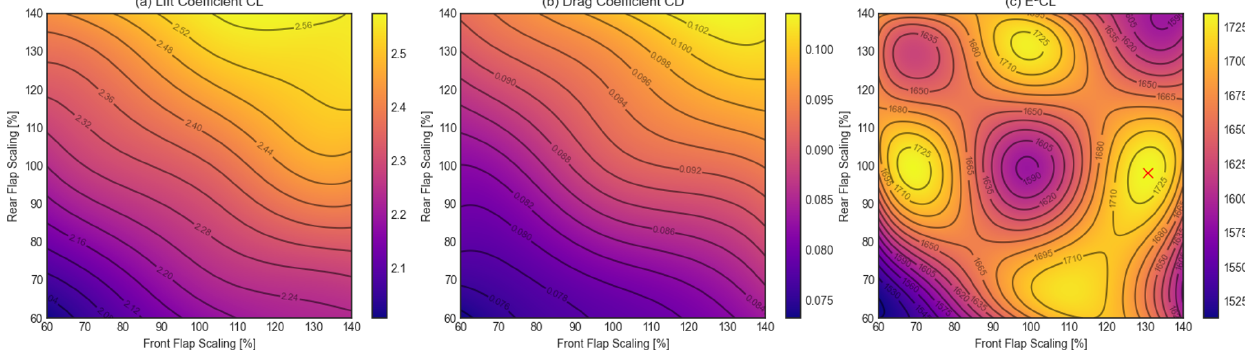
Figure 13. Effect of relative scale of front and rear flap on (a) C L , (b) C D and (c) E 2 C L